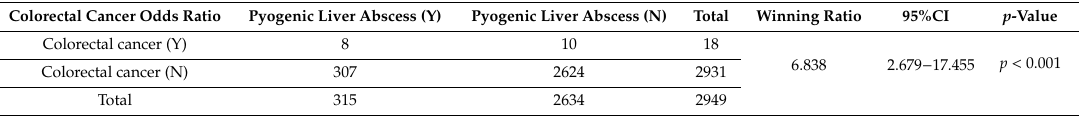
Table 5. Logistic regression colorectal cancer odds ratio.